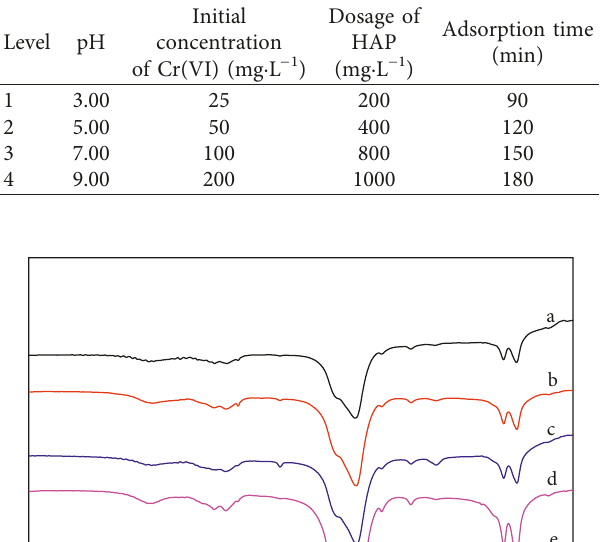
(222), (213), and (004), respectively (JCPDS number 03-0747) [19, 22]. It indicated that HAP was all formed with different molar ratio of chitosan to imidazole-4,5-